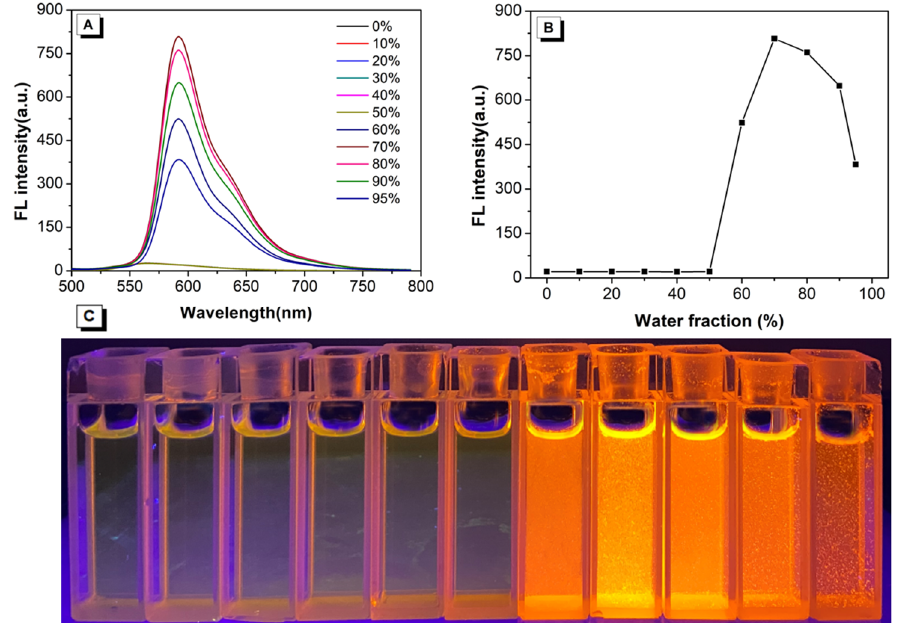
Figure 1. ( A ) Fluorescence spectra of L (40 μM) in tetrahydrofuran (THF)/water mixtures with different water fractions (λ ex /λ em = 428 nm/565 nm, slit: 5/5 nm, voltage: 660 v). ( B ) Plots of fluorescence intensity at 565 nm. ( C ) photographs in THF/water mixtures with different water fractions taken under 365 nm UV irradiation.